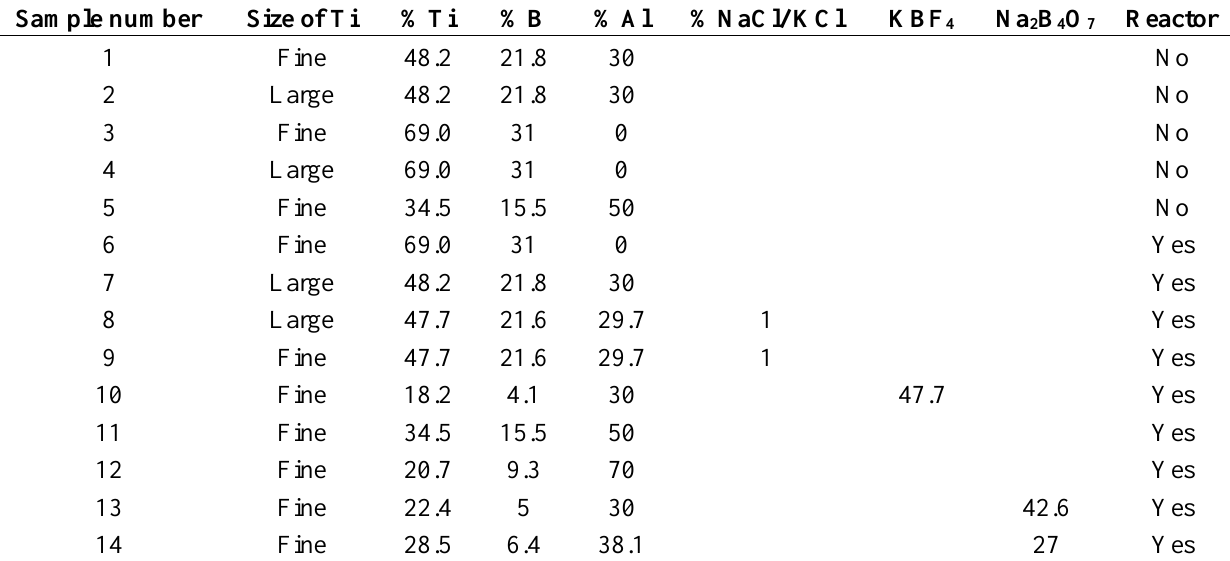
Table 2. Composition of tested master